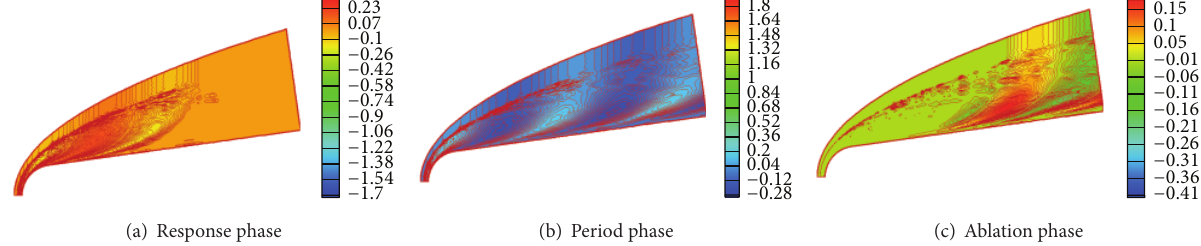
Figure 4: Contours of entropy disturbance in different phases.